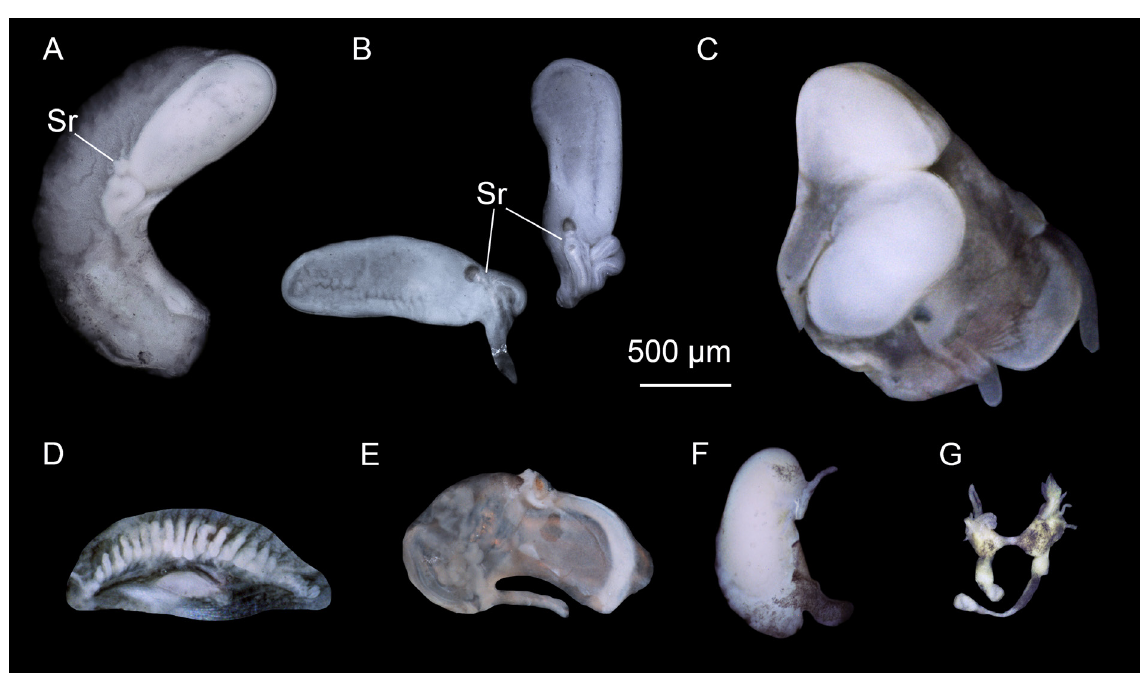
Fig. 19. Anatomy of Mercuria egarensis Miller, García-Guerrero & Ramos sp. nov. from Font de les Canyes, Barcelona, Spain. A . Female genitalia. B . Detailed view of the bursa copulatrix and seminal receptacle. C . Head and penis. D . Ctenidium and osphradium. E . Stomach. F . Prostate gland. G . Perioesophageal